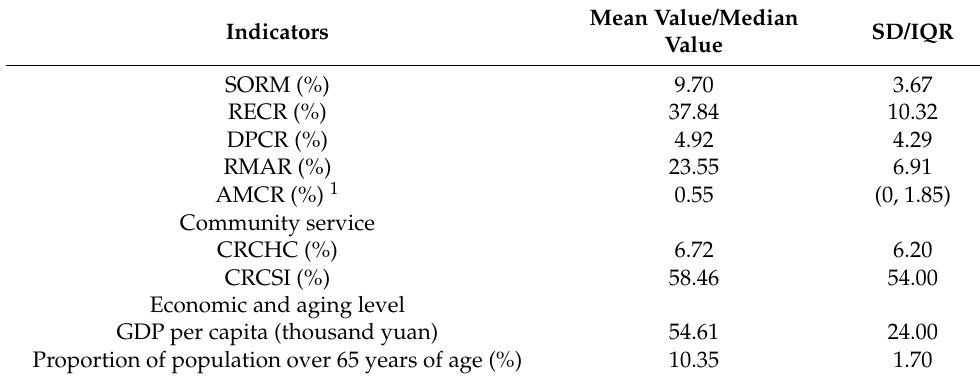
Table 2. Characteristics of SORM and variables at the provincial level in